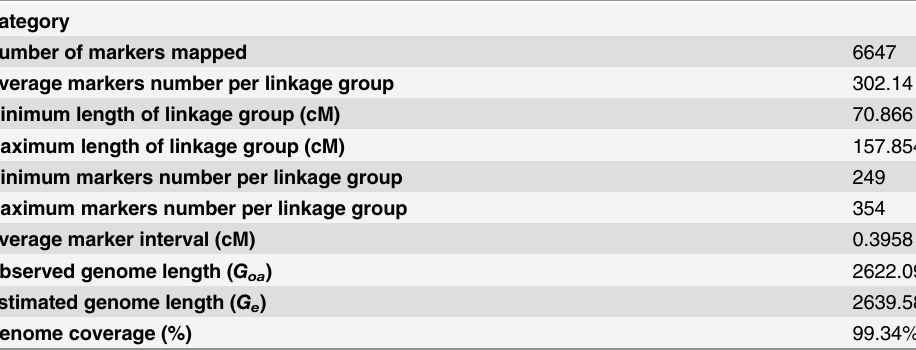
Table 4. Summary of turbot ( S . maximus ) consensus linkage